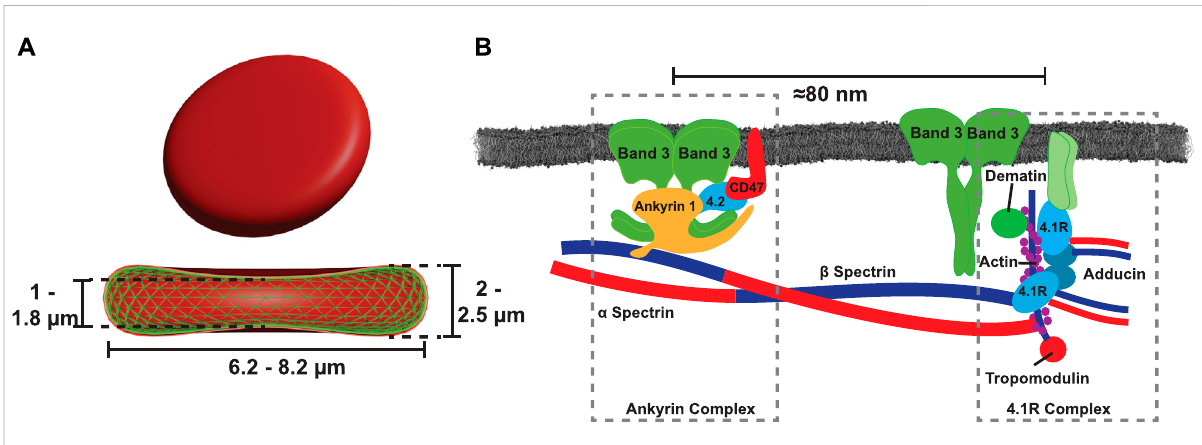
FIGURE 1 (A) HealthyRBCshaveadiscocyteshape,whichassemblestheminimalelasticenergyoftheRBC ’ sshell.Thistwolayeredshelliscomprisedofa cytoplasmic membrane tethered to a spectrin-based cytoskeleton. (B) The cytoplasmic membrane is tethered to the cytoskeleton via two protein complexes, the ankyrin-based complex, and the 4.1R-based complex (Gallagher,